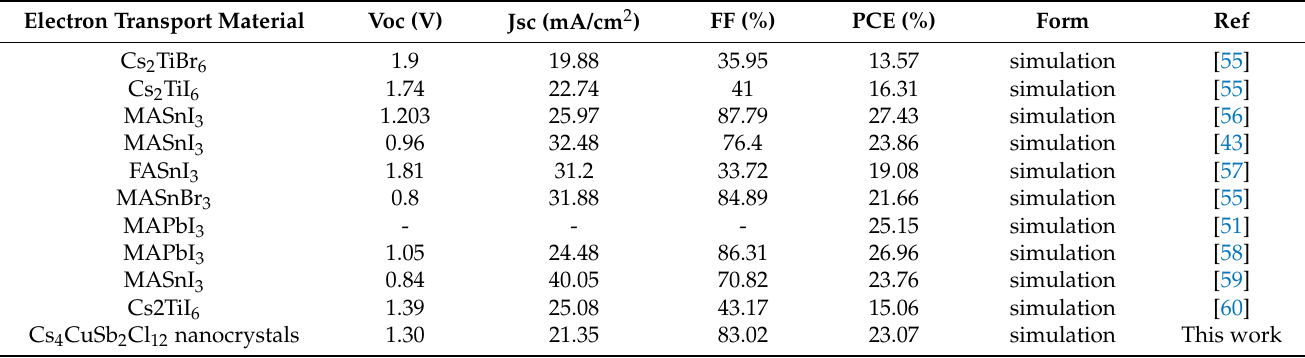
Table 6 provides a performance comparison among various works on lead-free PSC. It shows that different lead-free perovskite absorbers produce different PCEs, e.g., from 13.57% to 27.43%. The corresponding Voc, Jsc, FF values are in the range of 0.8 V~1.9 V, 19.88 mA/cm 2 ~40.05 mA/cm 2 , and 35.95%~87.79%, respectively. Although the values for Voc, Jsc, FF we obtained are not the highest among those lead-free PSCs, the PCE is very high. Our simulation results show that the PSC with structure of FTO/TiO 2 /CCSCNCs/ Cu 2 O/Au has an exciting PCE of 23.07%. It indicates that the CCSCNCs are very suitable for the absorber layer in PSC. Table 6. Performance analysis of various lead-free